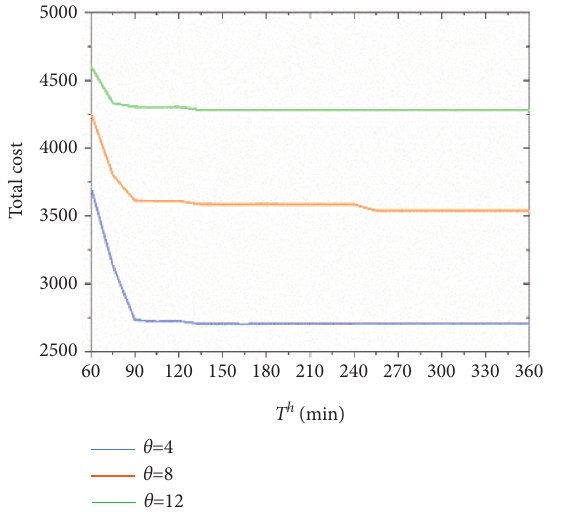
Figure 15: Results of the total cost with different buffer times.